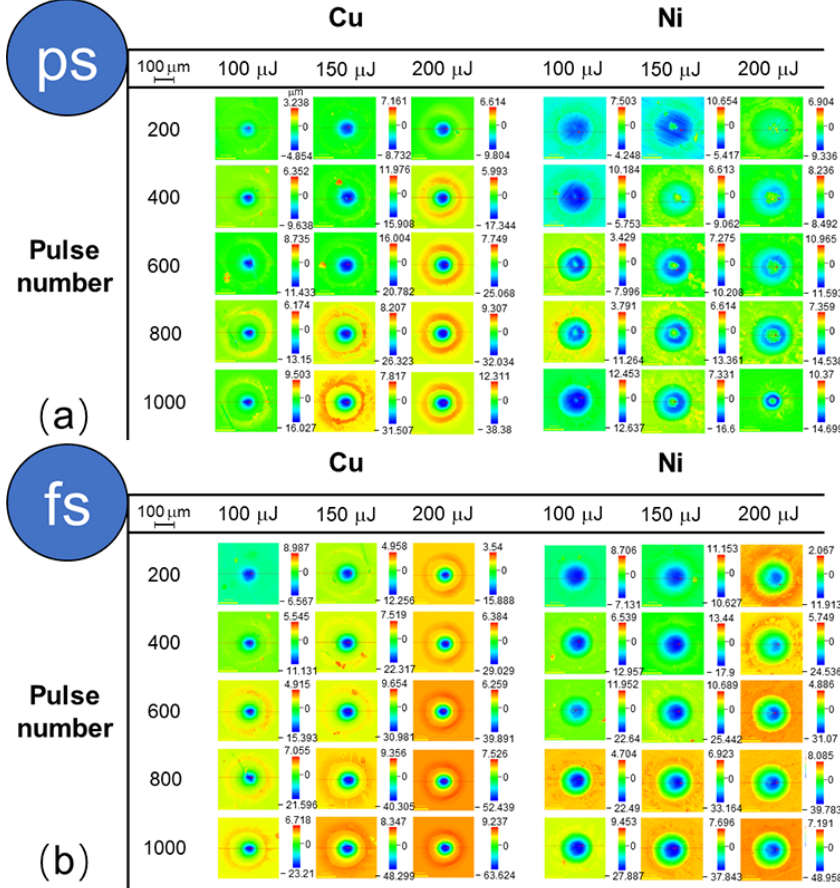
Figure 3. 3D profiles obtained by laser confocal microscopy for Ni and Cu specimens under different pulse energies and number of pulses for: ( a ) PLMA; ( b ) FLMA.